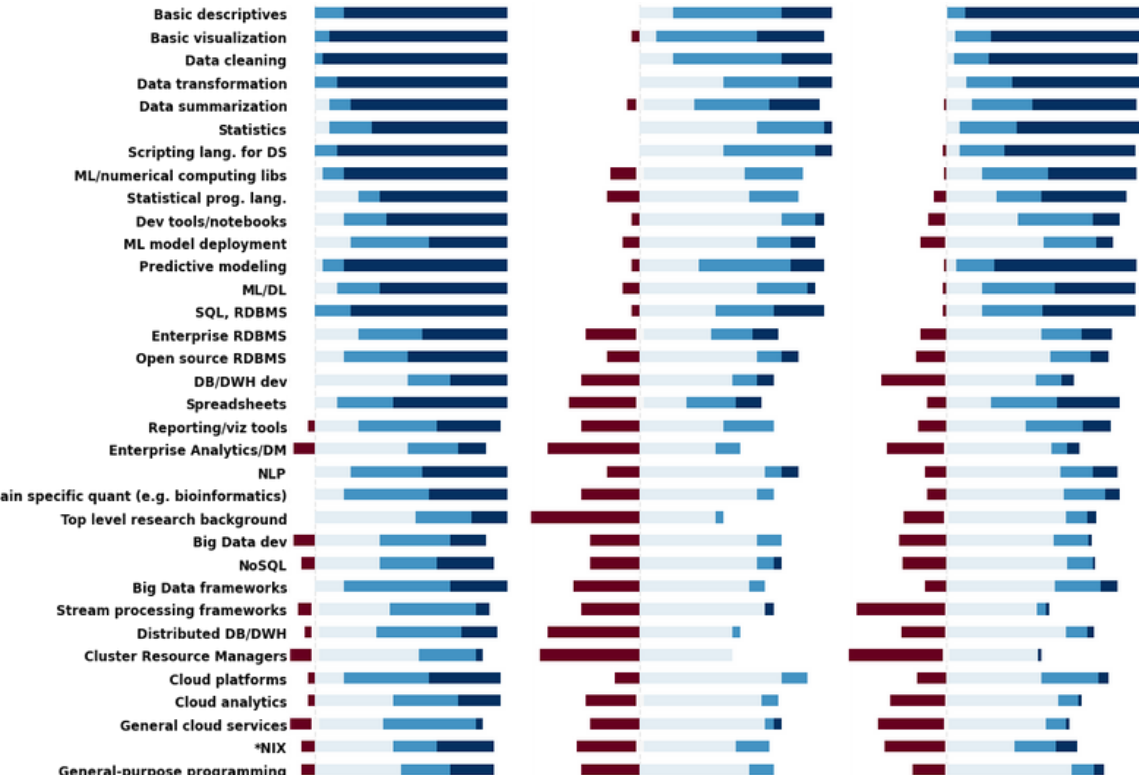
Figure 4. A summary of the questionnaire responses of the three subgroups of data scientists. The leftmost block of bars represents the identified data science unicorns. The middle block represents the low-expertise group, whereas the rightmost one represents the larger group, with a more concentrated set of skills than data science unicorns and clearly differentiated from the lower expertise group. The bars were generated in the same way as in Figure 3, and colors should be interpreted similarly. The bars are equi-length across the groups and the questionnaire items. See Appendix D for an explination of all abbreviations